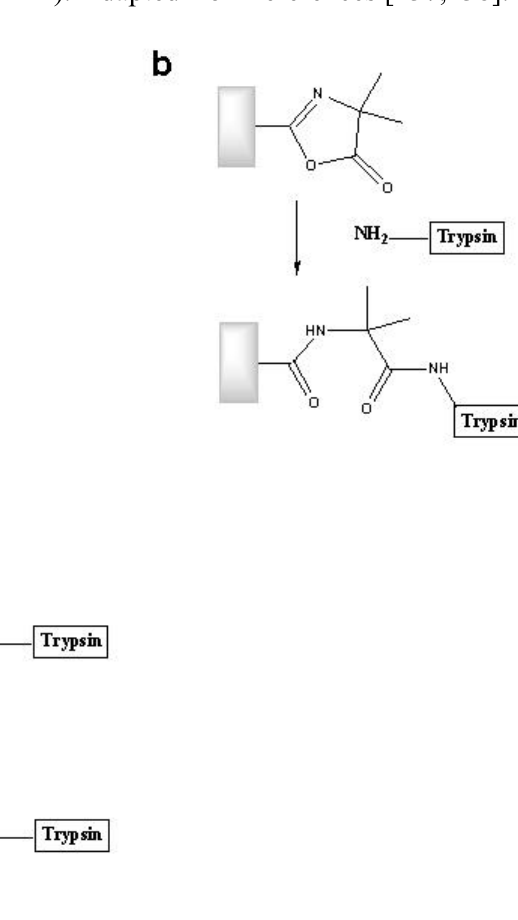
Figure 11. Sequence of reactions in immobilizing trypsin on rods of (a)